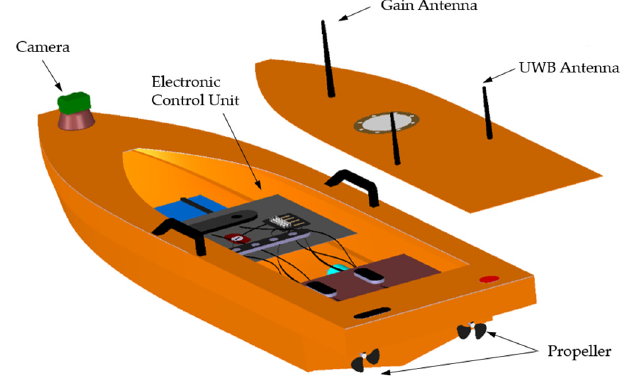
Figure 9. Composition diagram of the USV.